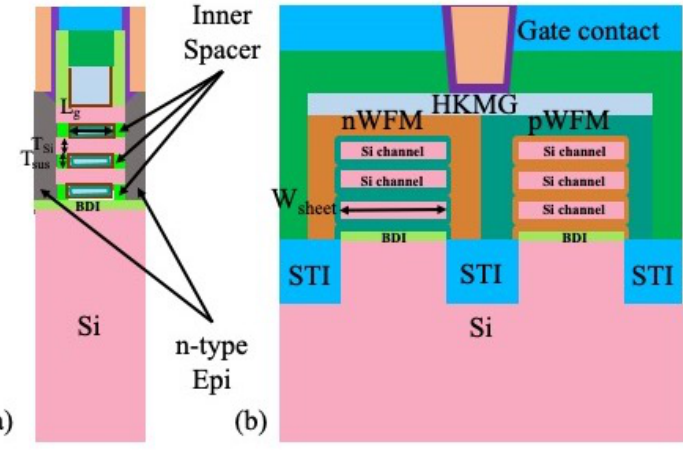
Figure 2. This figure shows a schematic for a gate-all-around nanosheet FET, with its key features highlighted. ( a ) shows a cut across the source-drain region where the key features highlighted are the bottom dielectric isolation (BDI), the thickness of the silicon channels ( T Si ), the distance between the silicon channels ( T sus ), and the gate length ( L g ). The inner spacer, and the n-type epi are also highlighted here. ( b ) shows a cut across the gate region where the key features highlighted are shallow trench isolation (STI), n-type work function metal (WFM), p-type WFM, the high-k metal gate (HKMG), and the sheet width ( W sheet